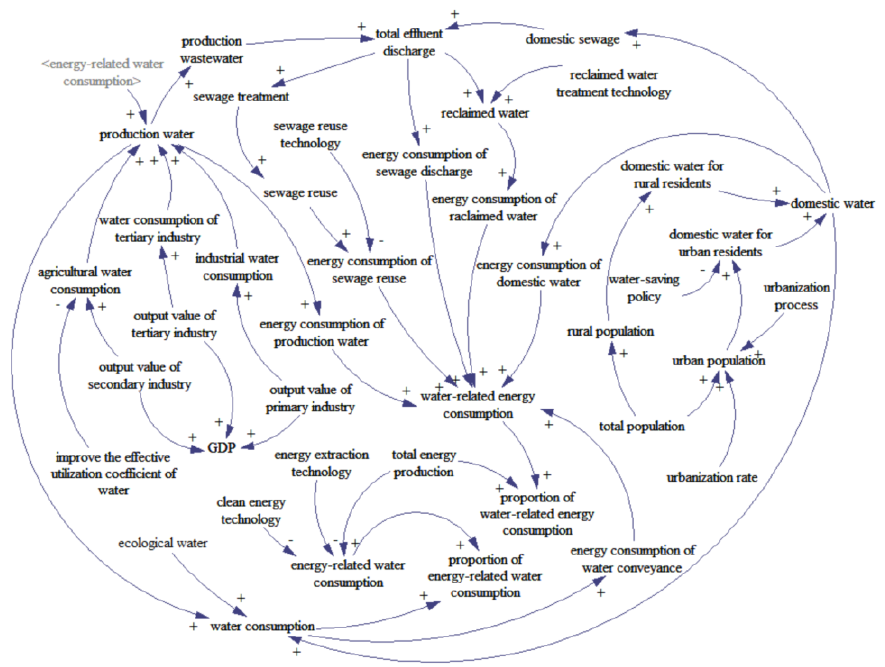
Figure 3. Causal loop diagram of the water – energy coupling system.